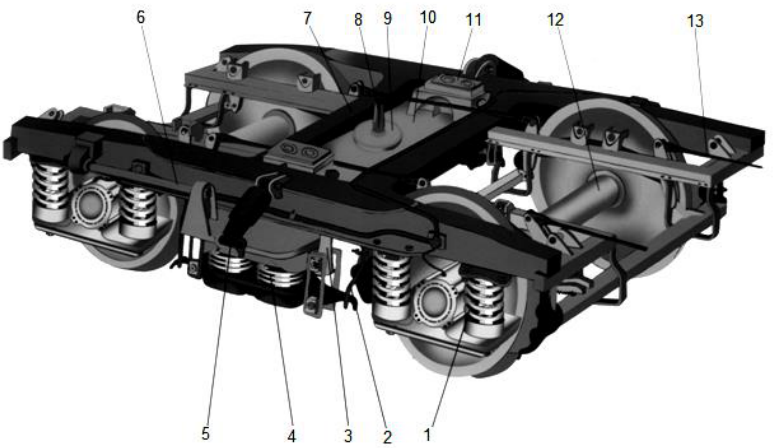
Figure 1. Design of KVZ-TsNII M Car Bogie: 1—axle-box suspension; 2—bracket; 3—elongated shackle; 4—central suspension; 5—hydraulic shock absorbers; 6—radius rods; 7—frame; 8—centre pivot; 9—centre bowl; 10—truck bolster; 11—side bearings; 12—two wheelsets; 13—brake rigging. According to their structural elements, the wheels of railway cars may be divided into tyreless (one-piece) and tyred (composite) wheels (Figure 2a,b).